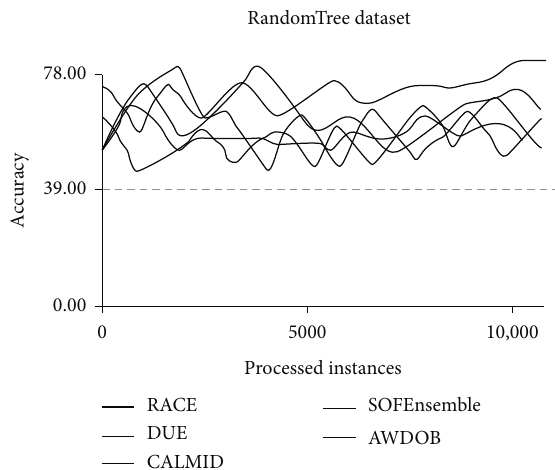
Figure 3: Prediction accuracy of the five algorithms on the Stagger dataset.